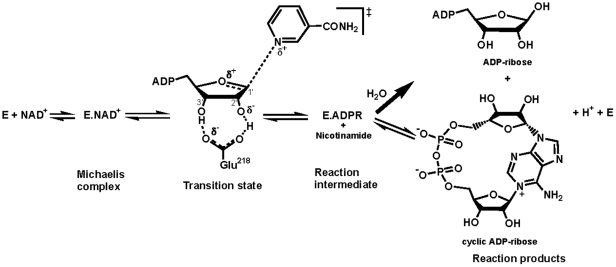
Partitioning reaction mechanism of bCD38.The nicotinamide-ribosyl bond of NAD+ is cleaved via a dissociative process with a late transition state, leading to a ribooxocarbenium ion reaction intermediate stabilized by the side-chain of invariant Glu218. This rate-determining step is followed by two nucleophilic reactions in competition: (i) an intermolecular pathway involving a rapid trapping from the β-face of this intermediate by a water molecule (NAD+ glycohydrolase activity) or by competing neutral nucleophiles such as pyridines (transglycosidation reactions) or alcohols (e.g., methanolysis), and (ii) an intramolecular reaction between N1 of the adenine ring and C1′ (anomeric carbon) of the oxocarbenium ion leading to the formation of cyclic ADP-ribose (ADP-ribosyl cyclase activity). This latter reaction represents a kinetically minor step (∼1% reaction products) relative to solvolysis.